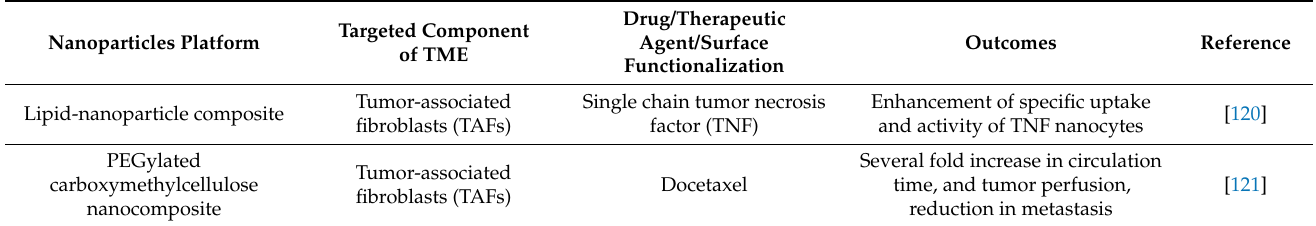
Table 2. Nanotherapeutic approaches to target cellular components of tumor microenvironment for overcoming cancer drug